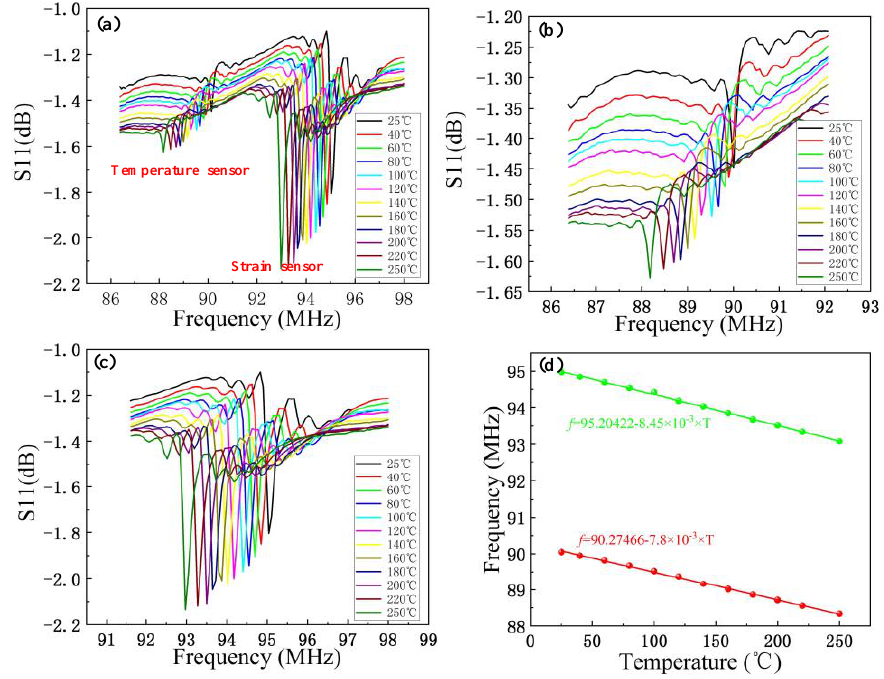
Figure 5. Temperature test results of the temperature–strain integrated sensor. ( a ) Temperature response curve of the dual-parameter sensor from 25 ◦ C to 250 ◦ C. ( b ) Enlargement of the temperature response curve of the temperature sensor. ( c ) Enlargement of the temperature response curve of the strain sensor. ( d ) The relation curve of temperature and frequency of each sensitive unit of the integrated multi-parameter sensor.